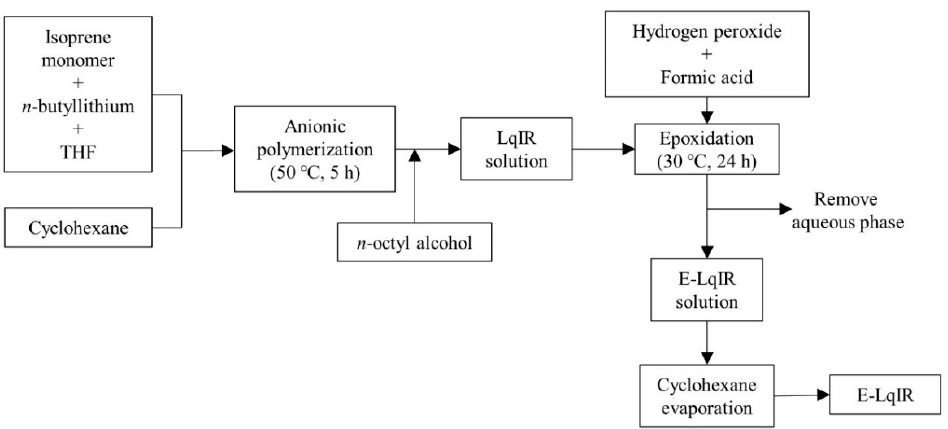
Scheme 1. Schematic flow chart of the E-LqIR synthesis process.